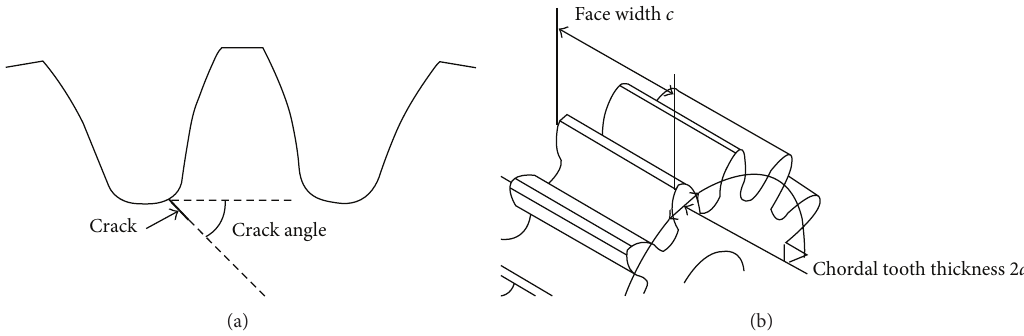
Figure 4: The diagrammatic view [24] of (a) the crack angle and (b) the face width and the chordal tooth thickness.